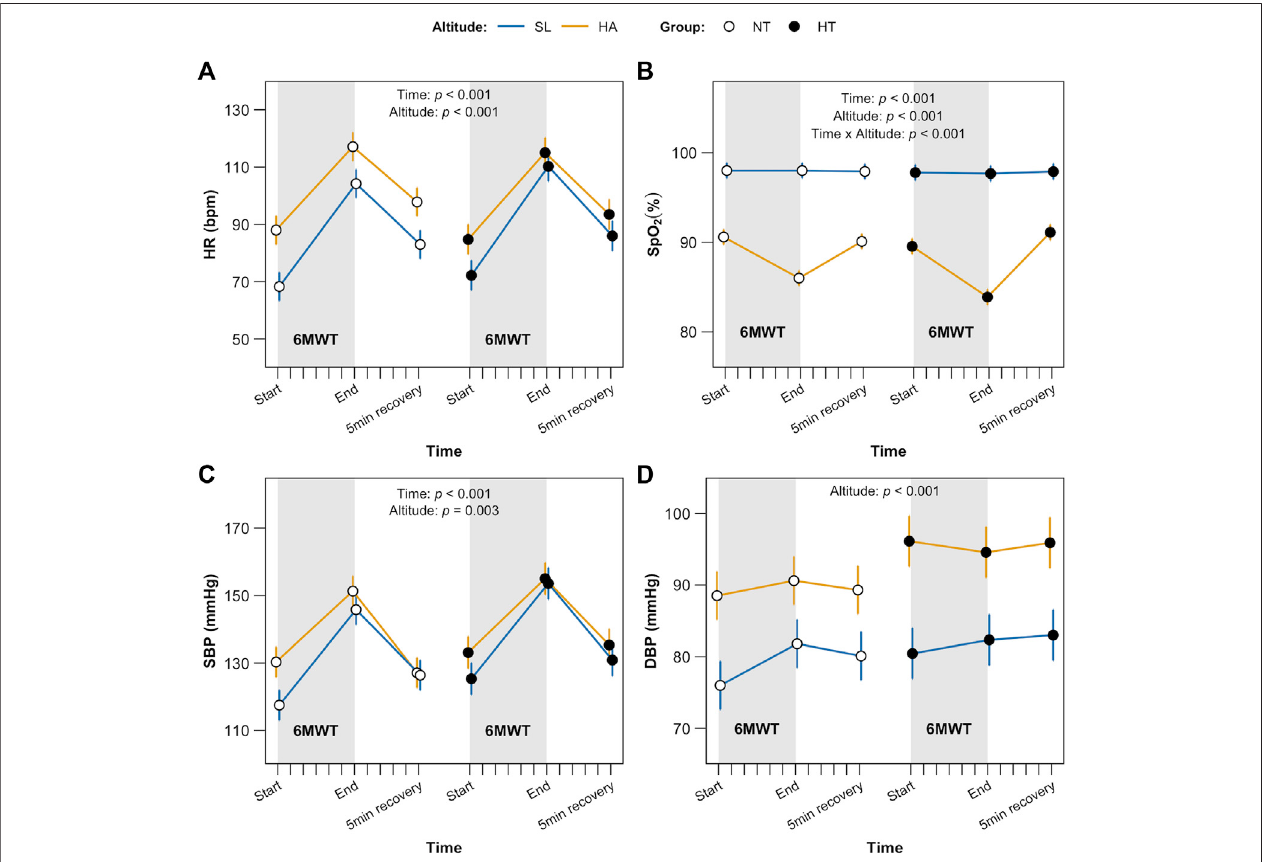
FIGURE4| 6MWTcomplimentarydata.Punctualmeasureofheartrate,HR (A) ,bloodoxygensaturation,SpO 2 , (B) ,systolicbloodpressure,SBP (C) anddiastolic blood pressure, DBP (D) , immediately before starting the 6MWT (= min 0, Time), at the end (= min 6 th , Time) of 6MWT and after 5-min recovery (= min 11 th , Time). Signi fi cant factors and interactions were HR and SpO 2 time and altitude (both p < 0.01); SpO 2 time and altitude ( p < 0.001). SBP time and altitude ( p < 0.001 and p = 0.003 respectively); DBP altitude only ( p < 0.001).